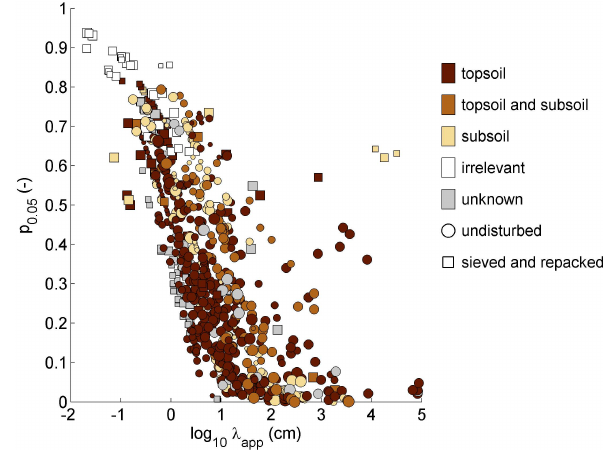
Fig. 7. Comparison of the apparent dispersivity, λ app , and normal- ized 5%-arrival time, p 0 . 05 , with sampling location of the respec- tive soil sample. The symbol size corresponds to the water fluxes, q , under which the respective experiment was conducted, small sym- bols indicating small water fluxes, large symbols denoting large wa- ter